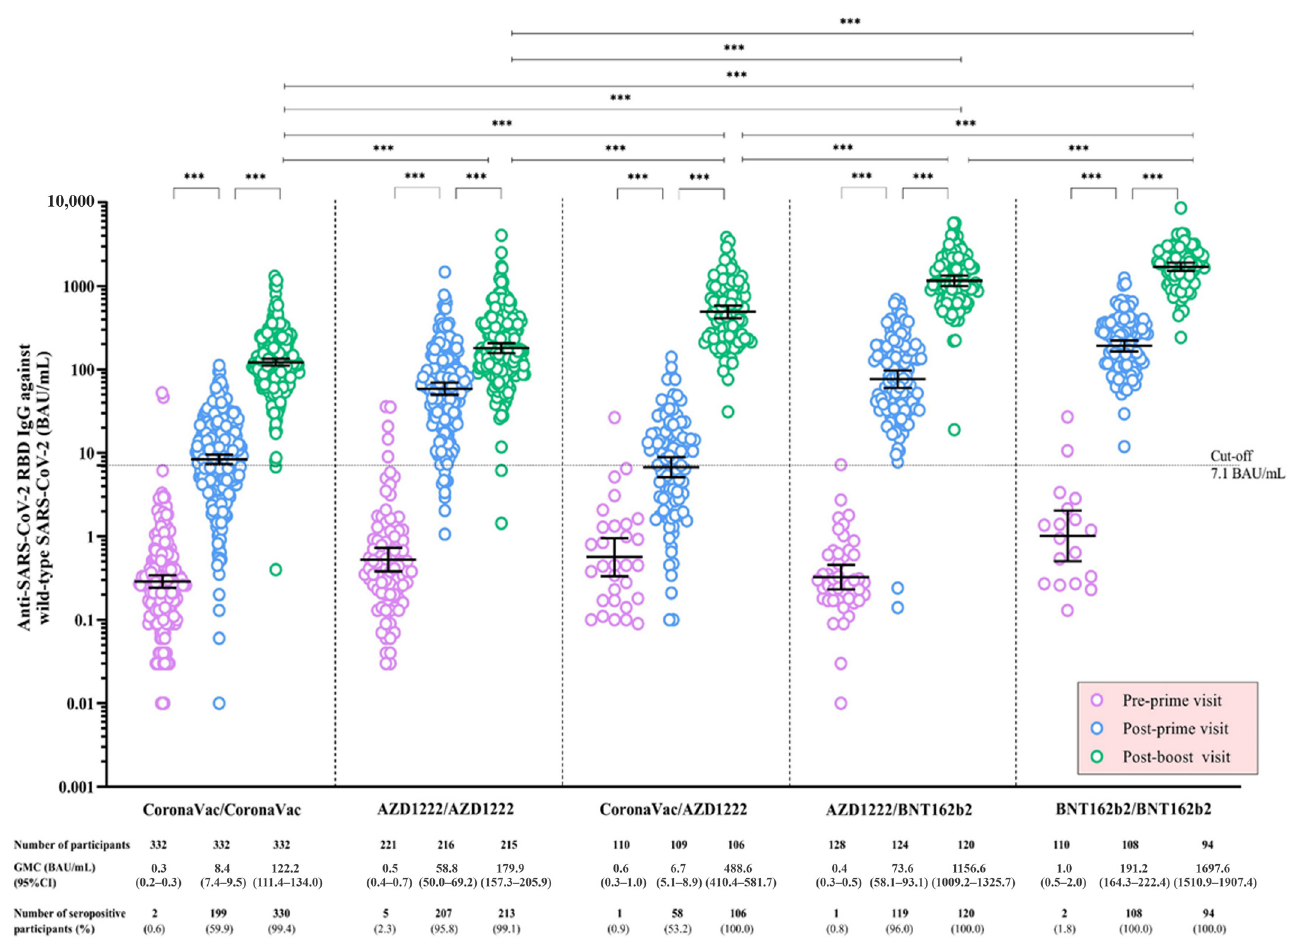
Figure 1. Anti-SARS-CoV-2 receptor-binding domain immunoglobulin G against wild-type SARS- CoV-2 following a primary series of COVID-19 vaccination, stratified by the COVID-19 vaccine regimen. Data points are the reciprocals of individual participants. The geometric mean concentrations (GMC) and the corresponding 95% confidence intervals (95% CI) of anti-SARS-CoV-2 receptor-binding domain immunoglobulin G against wild-type SARS-CoV-2 among all participants at the pre-prime, post-prime, and post-boost visits are shown as black solid lines. Black dotted lines indicate the cut-off values. The mixed-effects log-linear regression analysis was performed to compare the GMCs of anti-SARS-CoV-2 receptor-binding domain immunoglobulin G between visits within each COVID-19 vaccine regimen. The log-linear regression analysis was performed to compare the GMCs of anti-SARS-CoV-2 receptor-binding domain immunoglobulin G between COVID-19 vaccine regimens. *** indicates p < 0.001 for the comparison of the GMCs of anti-SARS-CoV-2 receptor-binding domain immunoglobulin G between indicated visits within each vaccine regimen, and between indicated vaccine regimens. Abbreviations: AZD1222 vaccine, the Oxford-AstraZeneca COVID-19 vaccine; BAU, binding antibody unit; BNT162b2, Pfizer-BioNTech vaccine; COVID-19, coronavirus disease 2019; GMC, geometric mean concentration; IgG, immunoglobulin G; RBD, receptor-binding domain; SARS-CoV-2, severe acute respiratory syndrome coronavirus-2; 95% CI, 95% confidence interval.